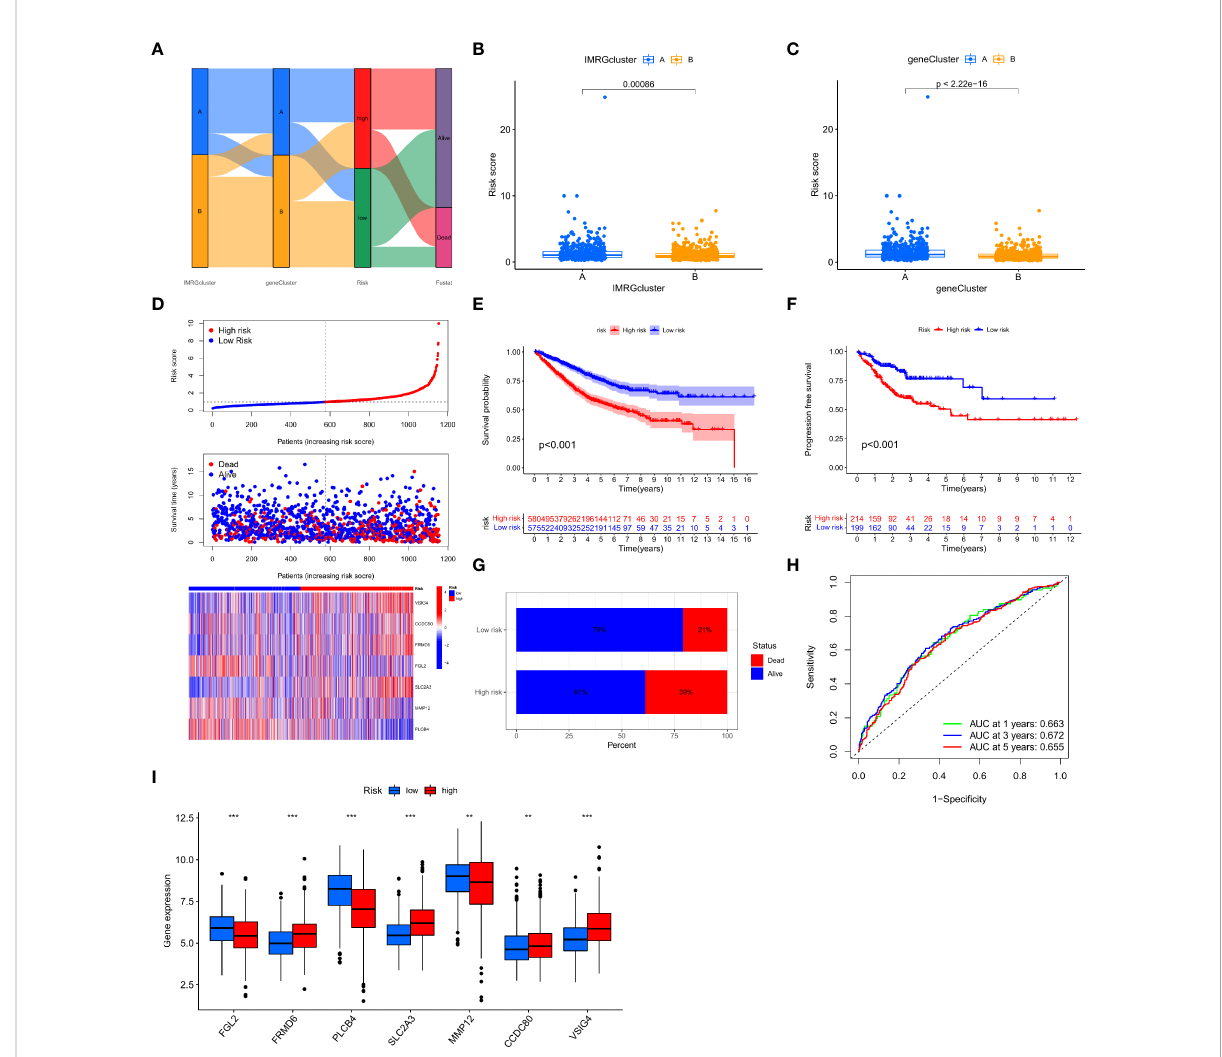
FIGURE 4 Construction and validation of the IMRG risk scores. (A) Sankey plots representing the relationships of IMRG clusters, gene clusters, IMRG risk scores, and survival status; (B) Comparison of the differential risk scores between the two IMRG clusters; (C) Comparison of the differential risk scores for IMRGs between the two gene clusters; (D) Risk distribution, survival status, and related gene expression of IMRGs risk score; (E) Comparison of OS rates between the high- and low-risk groups; (F) The PFS contrast between the high- and low-risk groups; (G) Survival ratio of patients in the high-risk and low-risk groups; (H) The ROC curves were performed according to the IMRG risk scores versus the survival sensitivity and speci fi city as measured at 1-, 3-, and 5-year; (I) Differential expression of the seven genes constructing the model in high-risk and low-risk groups; ***p < 0.001; **p <